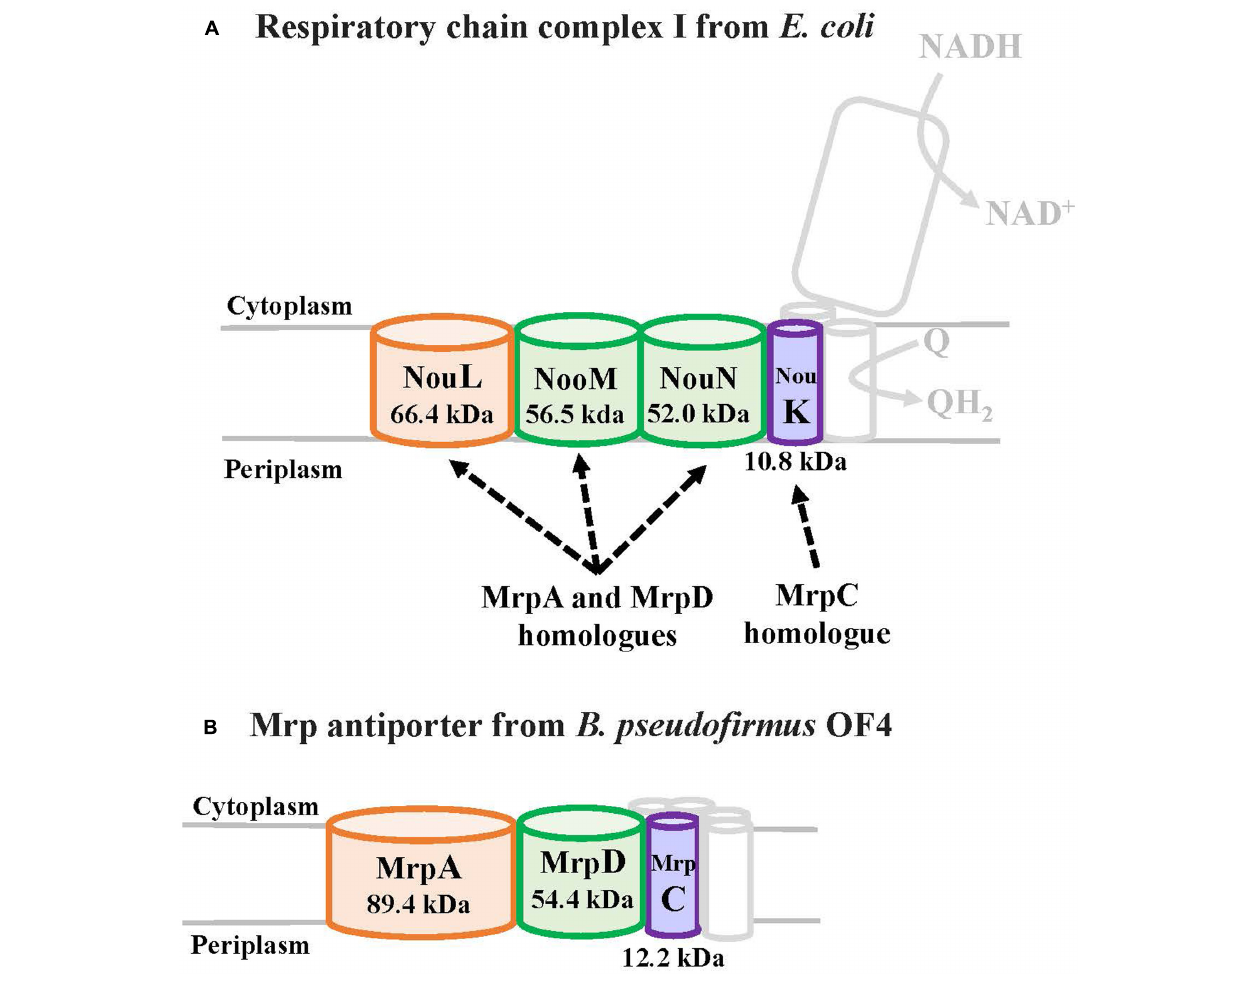
FIGURE 3 | The E. coli respiratory chain complex I subunit with homology to the Mrp subunit. (A) Schematic diagram of respiratory chain complex I. The NuoL, NuoM, and NuoN subunits of the E. coli respiratory chain complex I have homology with the MrpA and MrpD subunits of the Mrp antiporter, and the NuoK subunits also have partial homology with the MrpC subunit (Mathiesen and Hägerhäll, 2003). (B) Schematic diagram of Mrp